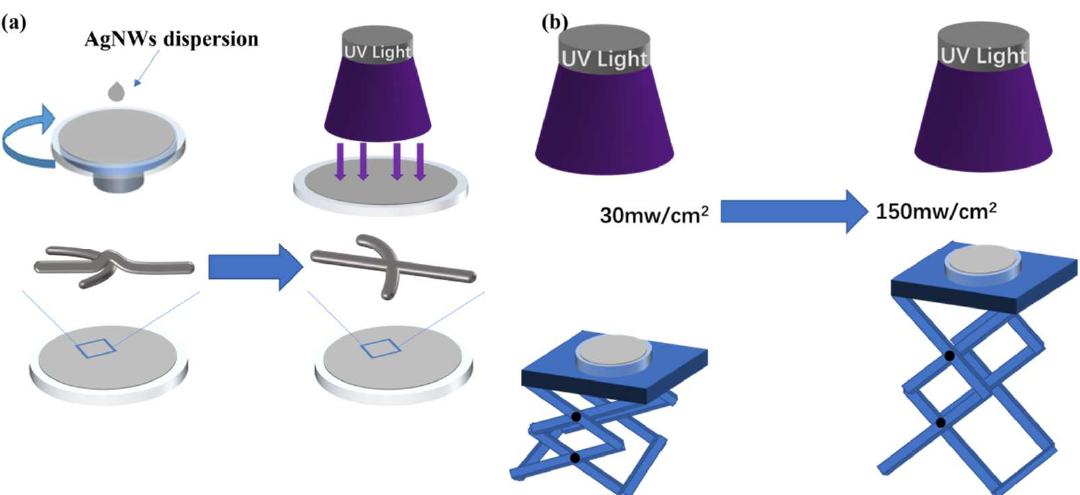
Figure 1. Schematic diagram of the UV irradiation of AgNWs. ( a ) Schematic diagram of welding principle. ( b ) Schematic diagram of optical power regulation principle.